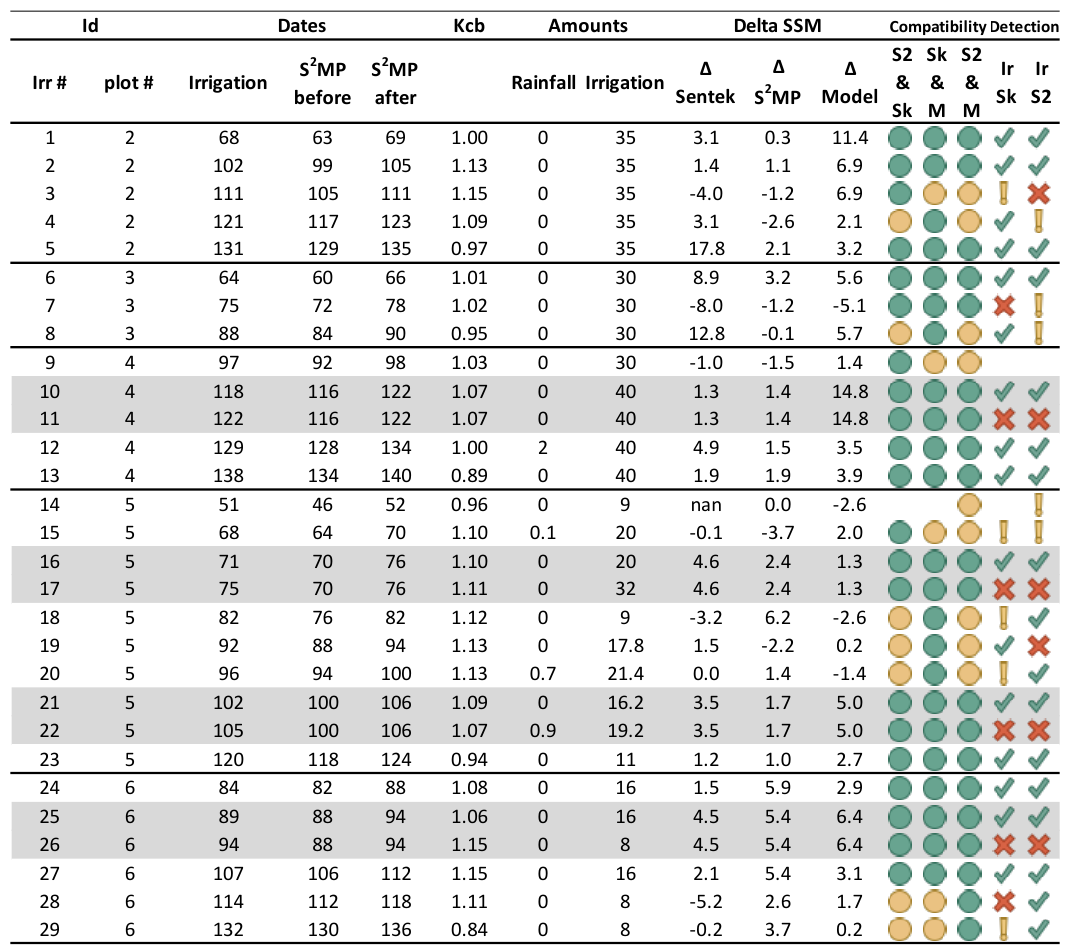
Figure 4. Summary of each recorded irrigation event: The “compatibility” (same variation) between two sources (S2 for S 2 PM, Sk for in situ, M for Model) is indicated by a green circle, and a yellow circle on the contrary. In the “Detection” columns, a green tick corresponds to an increase in both SSM, a red cross corresponds to a opposite variation, or impossibility of detection due to the time step of observations. The yellow exclamation mark indicates a possible mismatch with the next time interval. The gray lines indicate when two irrigations occur between two S 2 PM observations.